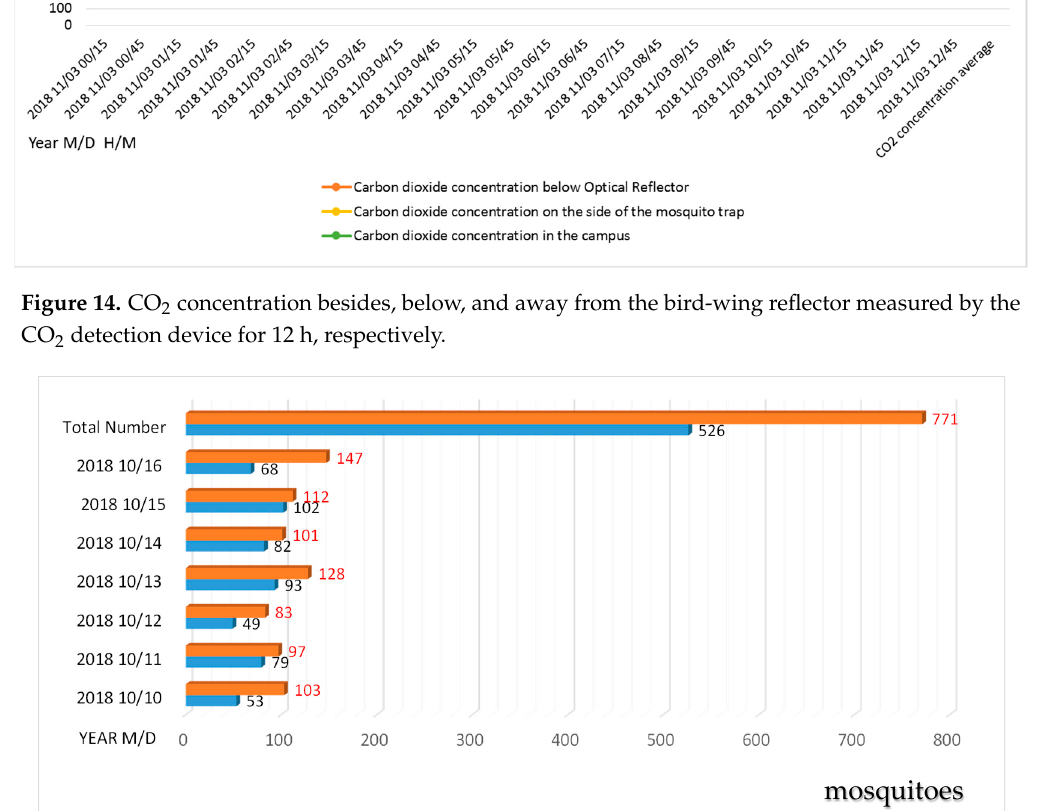
Figure 15. Comparison of mosquito trapping ability between the Type (c) mosquito trapping system with the bird-wing optical reflector, and that coated with TiO 2.